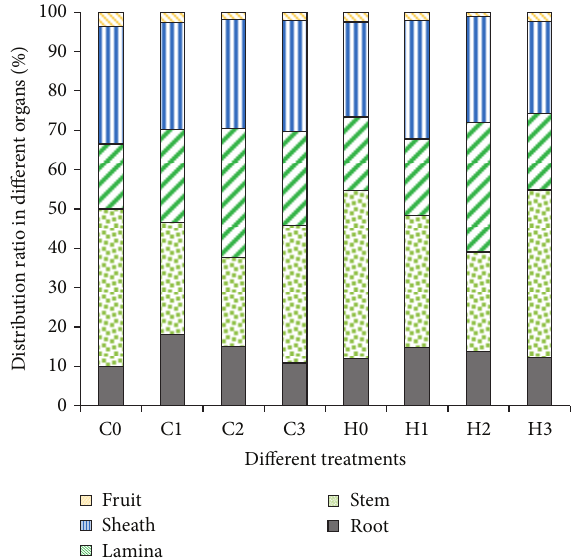
Figure 4: The Cd distribution fractions in different treatments. The leaf fraction is equal to the sum of the sheath and the lamina